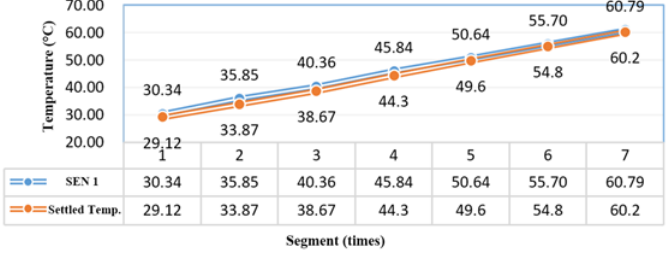
Figure 1. Temperature increase trend of Sensor 1. Table 2. Temperature interval data of Sensor